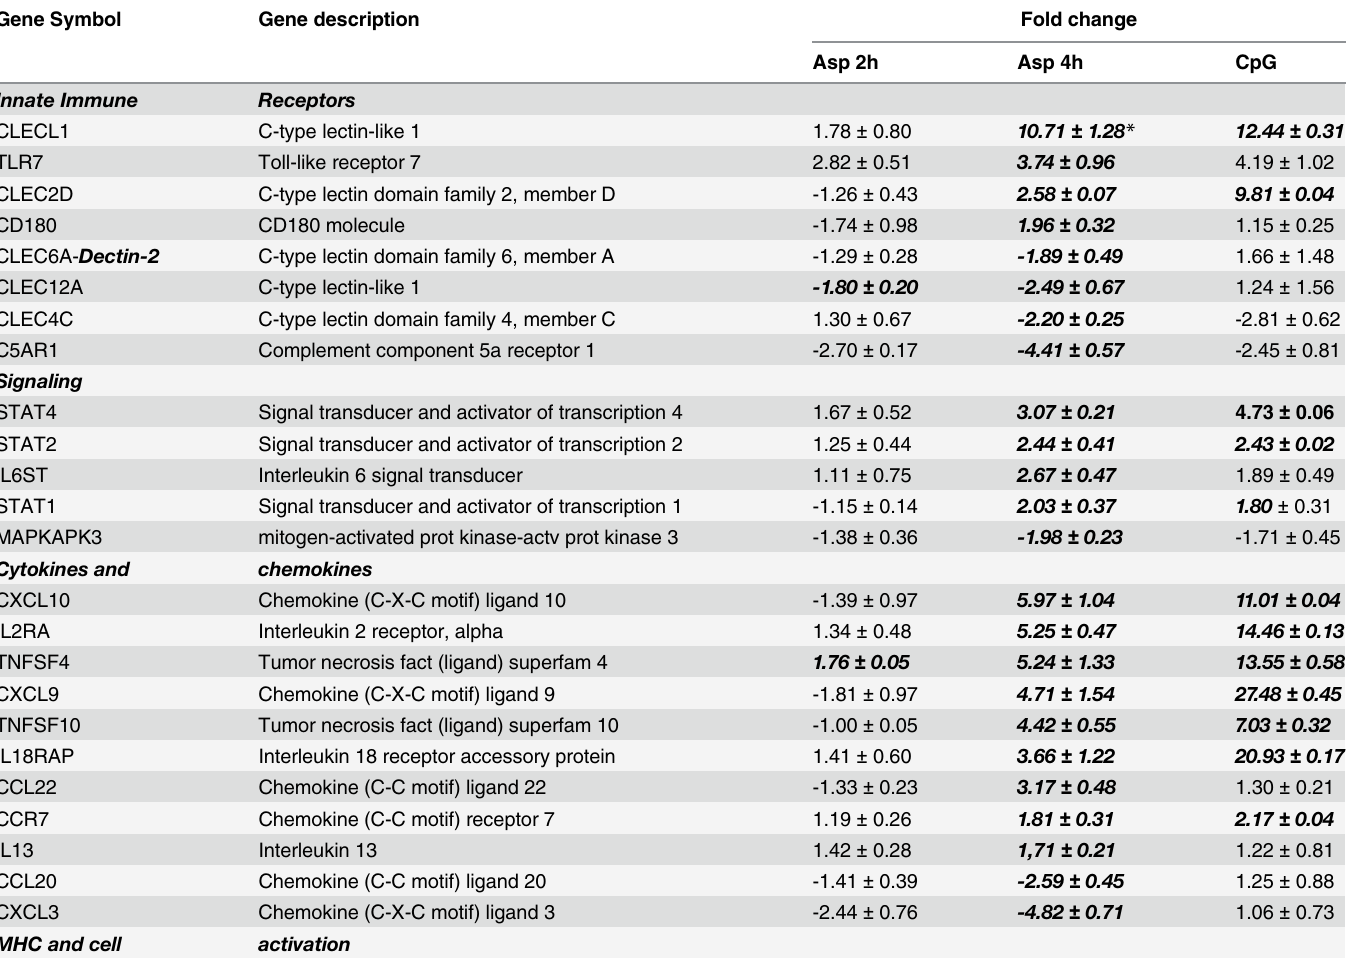
Table 1. Dendritic cell